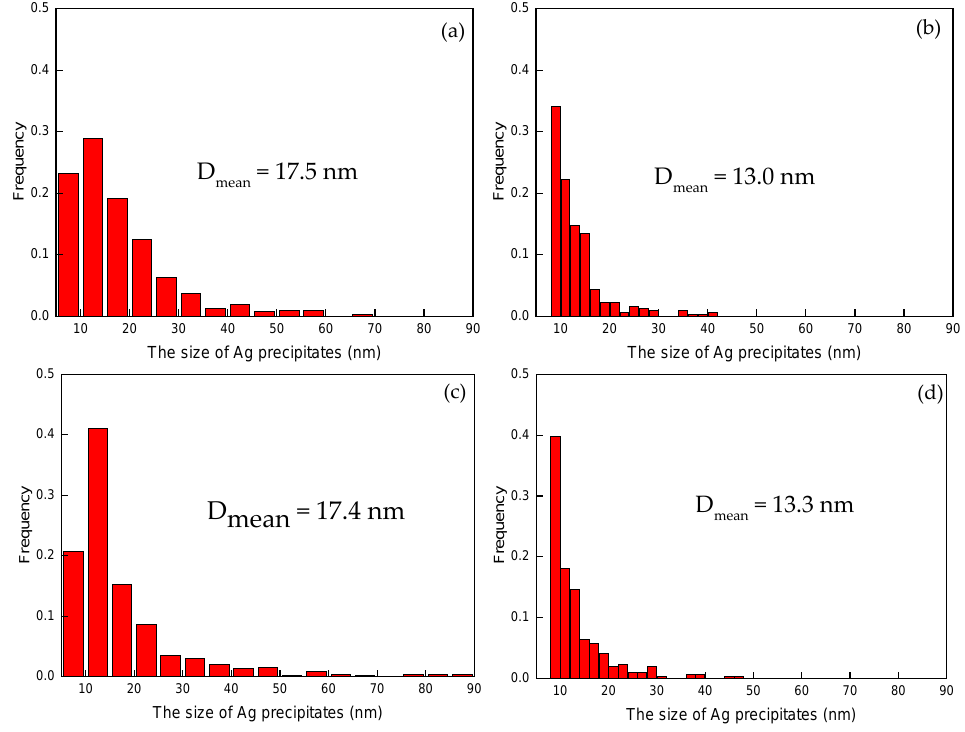
Figure 5. Histogram of the distribution of Ag precipitates in the Cu matrix at various temperatures for 4 h. Fe-free alloy: ( a ) 450 °C; ( c ) 500 °C; Fe-doping alloy: ( b ) 450 °C; (d) 500 °C .